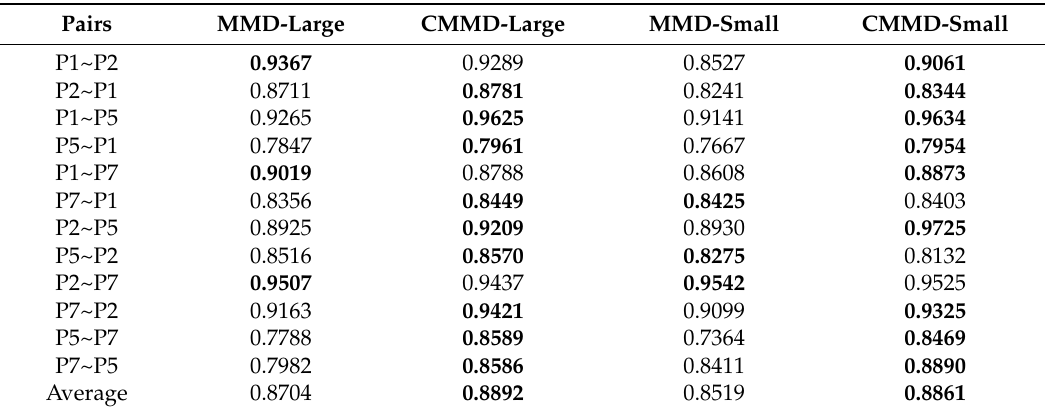
Table 10. Experiment result of MMD and CMMD on UCI. Large indicates that the Target uses more unlabeled data under the experimental conditions shown in Table 4. Small indicates that the Target uses less unlabeled data under the experimental conditions shown in Table 5. The bold result means it is bigger than another result in the same row with the same condition (Large or Small). The same with Table